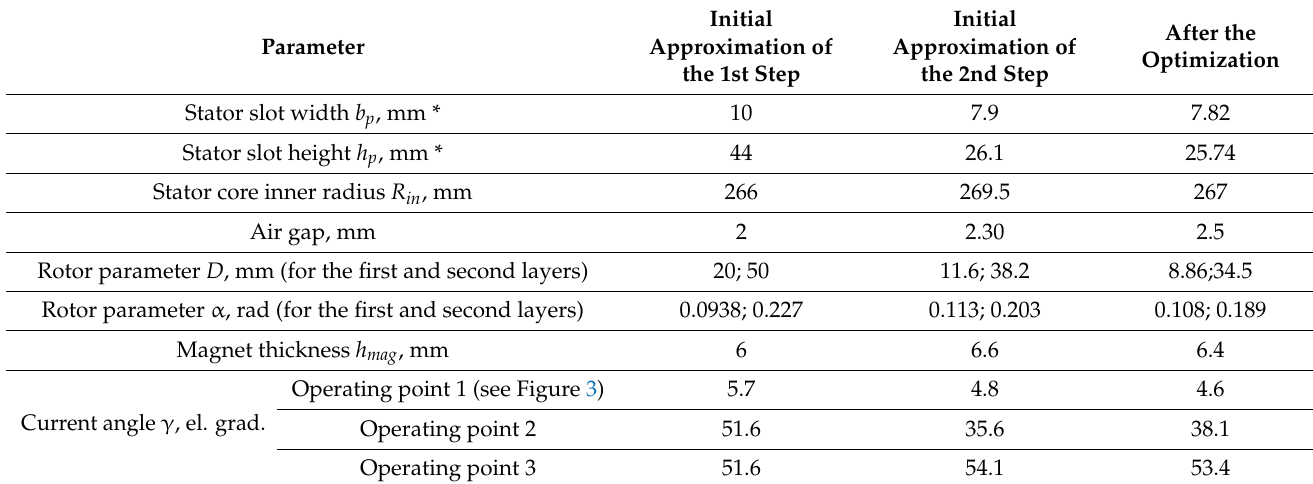
Table 3. IPMSM parameters varied during the optimization.